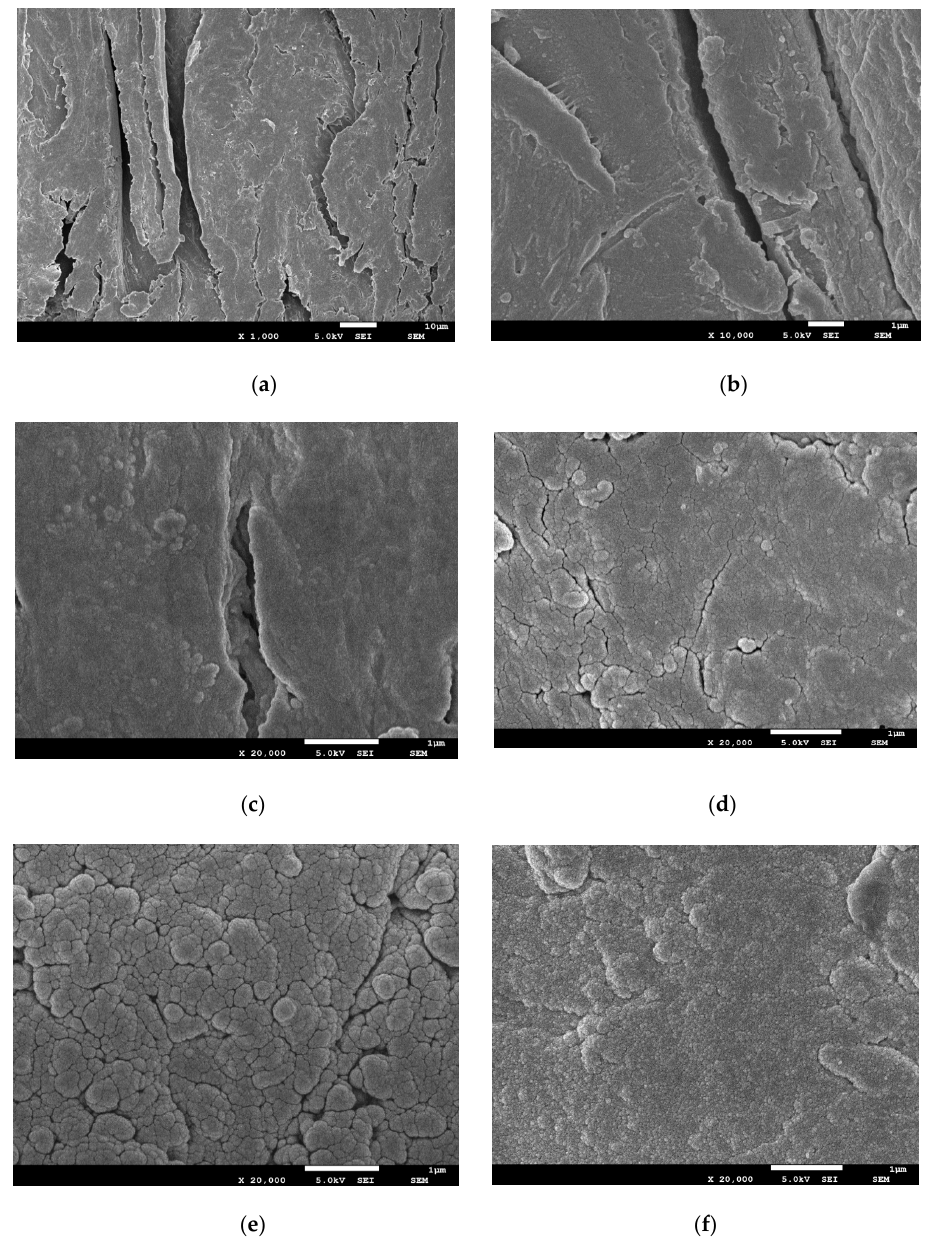
Figure 7. Metallized wood veneers scanning electron microscopy (SEM), ( a ) Ultrasonic treatment wood; ( b ) Magnetron sputtering for 50 s; ( c ) Magnetron sputtering for 150 s; ( d ) Magnetron sputtering for 10 min; ( e ) Magnetron sputtering for 15 min; ( f ) Magnetron sputtering for 15 min (200 °C).